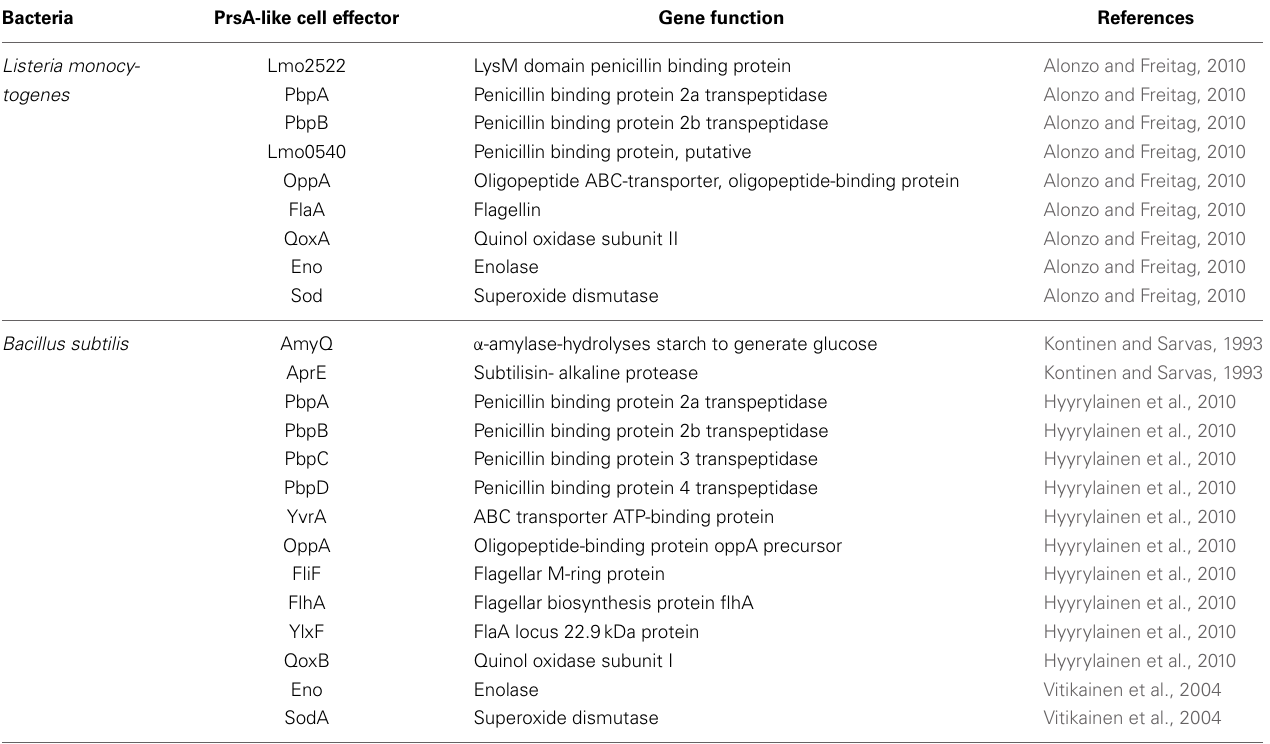
Table 1 | Potential PrsA2/PrsA substrates relevant to bacterial cell